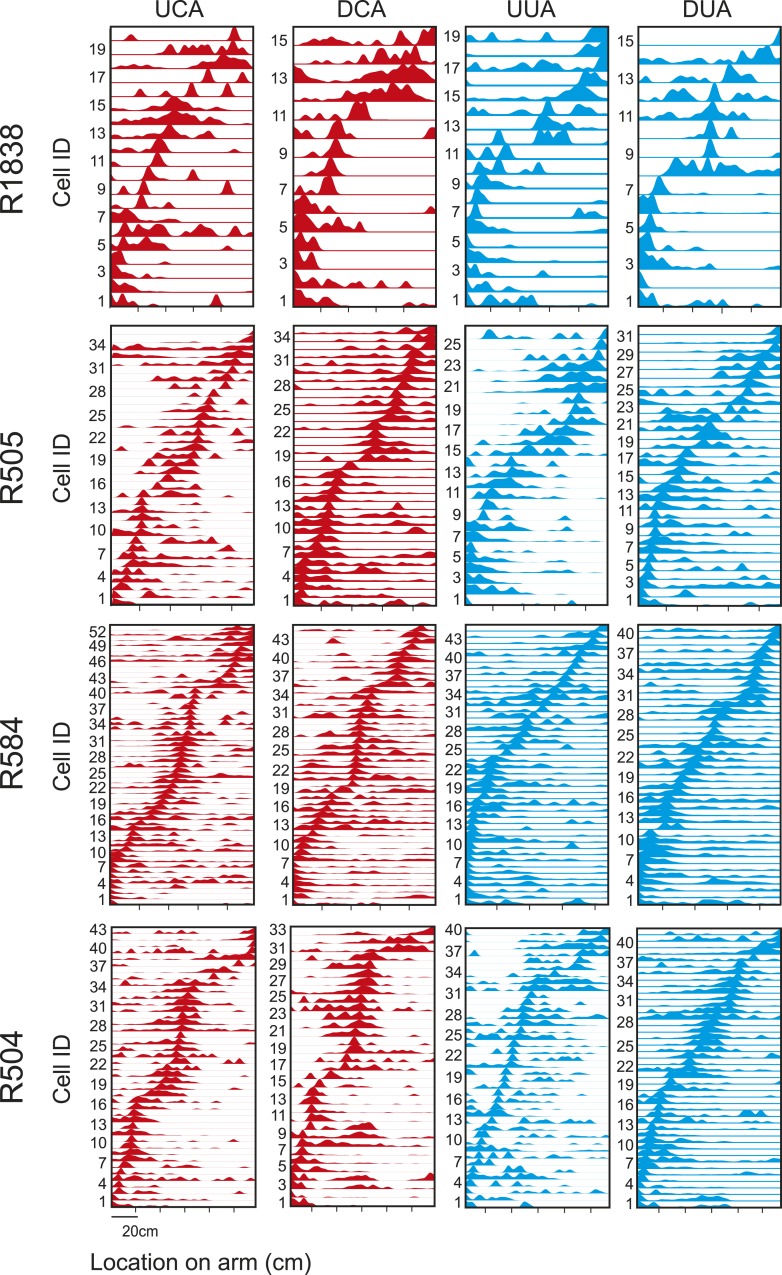
Place cell templates place cell sequences for each template.Cells are ordered according to the location of their place field. x-axis shows location on arm (cm)—left side closer to the stem, and y-axis cell IDs. UCA = Up Cued Arm, DCA = Down Cued Arm, UUA = Up Uncued Arm, DUA = Down Uncued Arm.